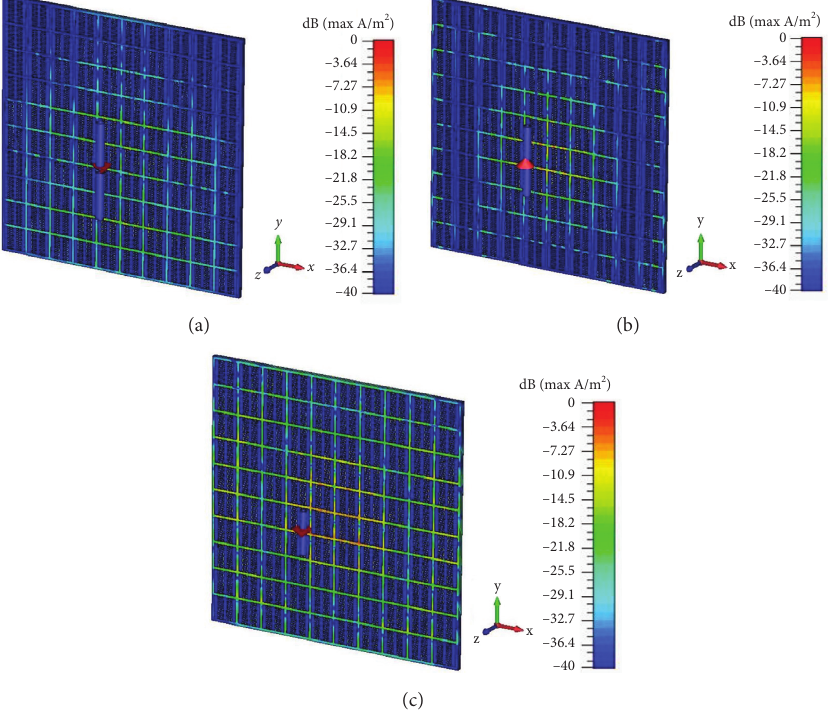
Figure 14: The simulation current density results of dipole antenna effect on ICPW-EBG reflector: (a) 1.8 GHz, (b) 2.45GHz, and (c) 3.7GHz.